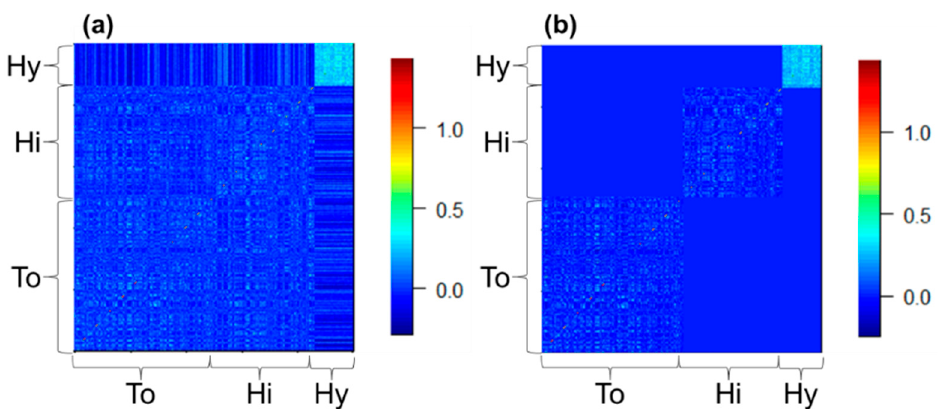
Figure 1. Heatmaps of the two genomic relationship matrices (G matrices). To, Hi, and Hy, the steers marketed within Tottori, Hiroshima, and Hyogo prefectures in Japan. ( a ) The G matrix used to consider allele substitution effects common among To, Hi, and Hy steers ( G 1 matrix in the main text);